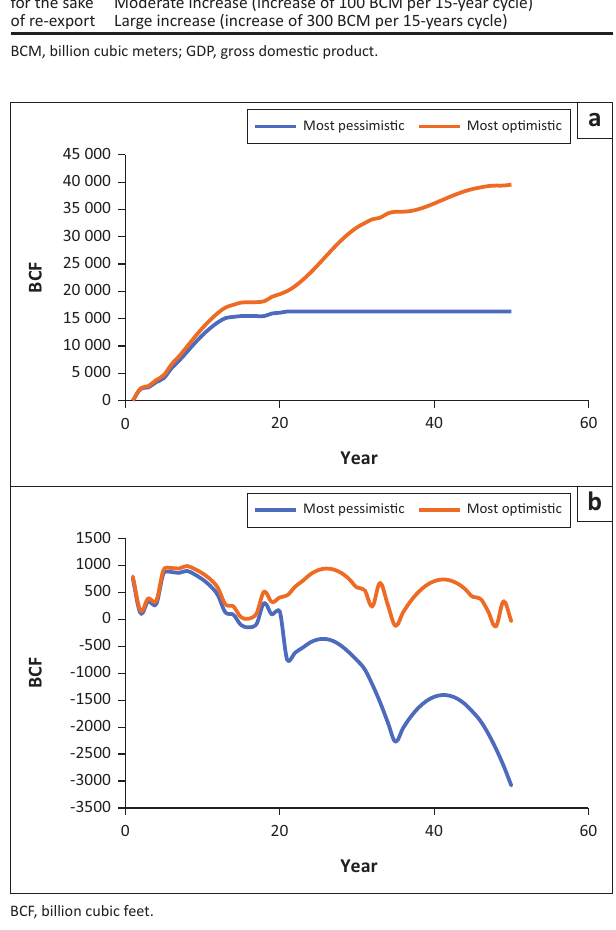
FIGURE 7: Most optimistic case versus most pessimistic case. (a) Effect on Present Value; (b) Effect on Export Quantity.